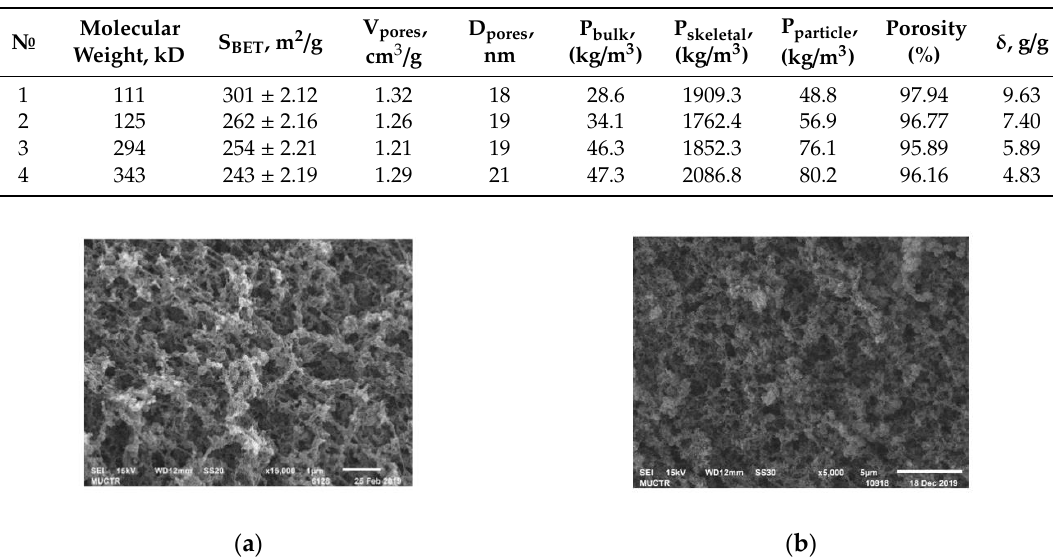
Table 1. Results of the Analytical Experiments.